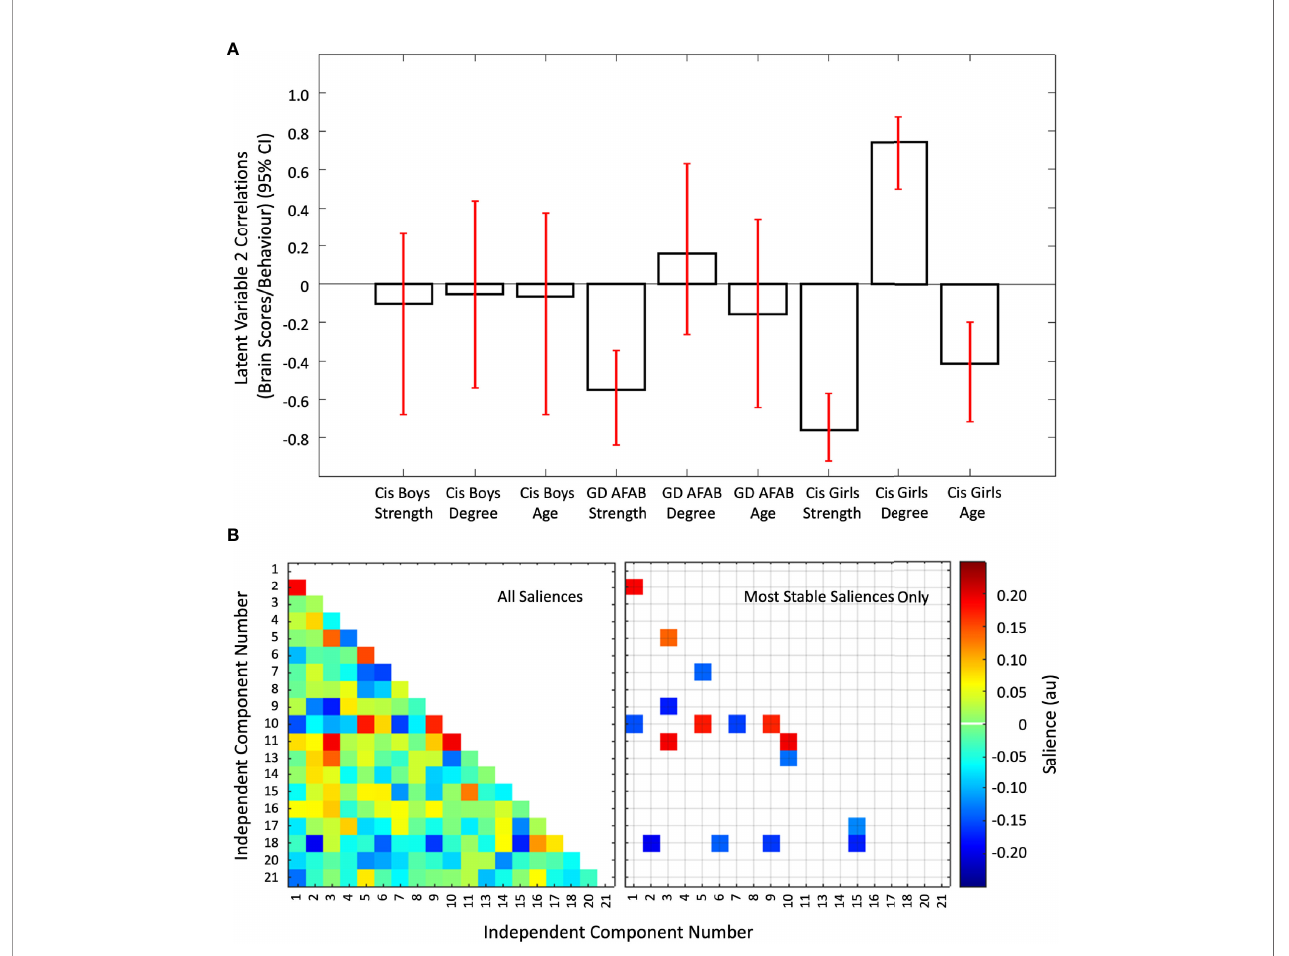
FIGURE 5 | The second latent variable re fl ecting correlations of independent component pairs with age, strength of sexual attractions, and degree of sexual attractions. Panel (A) Cis = cisgender, Strength = strength of sexual attractions, Degree = degree of androphilia-gynephilia. Correlations of brain scores with behavior (± 95% con fi dence interval, CI) from the second signi fi cant latent variable in the second PLS analysis. This latent variable identi fi ed stable correlations in cisgender girls and GD AFAB (gender dysphoria, assigned female at birth). For cisgender girls, correlations were stable for strength of sexual attractions, age, and degree of androphilia-gynephilia. No correlations were stable in the cisgender boys and only strength of attractions was stable in GD AFAB participants. Scatterplots of brain scores by behavioral measures for all participants can be found in Figure S2 ( Supplementary Material ). Panel (B) Heat maps of the brain saliences (left) and stable saliences (right) for 19 independent component (IC) pairs. This latent variable included stable positive and negative saliences in 16 IC pairs, shown on the right. ICs 12, 19, and 22-25 were discarded as noise or non-gray matter signal. Network names are in Table 1